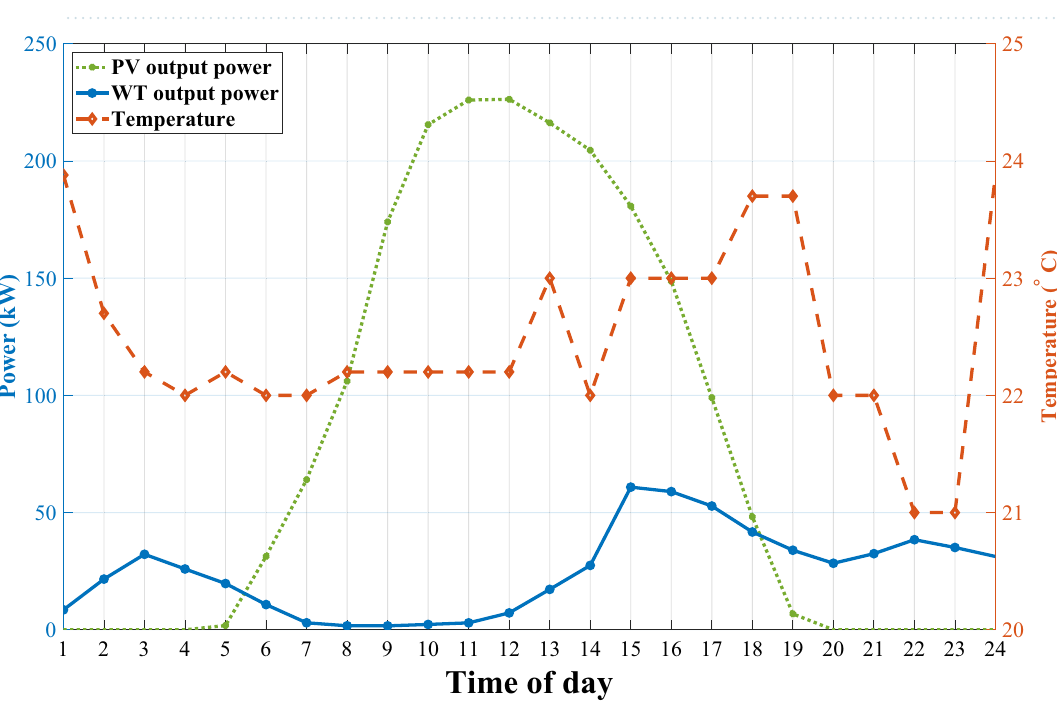
Figure 4. The Gasa island RESs output power and daily temperature during